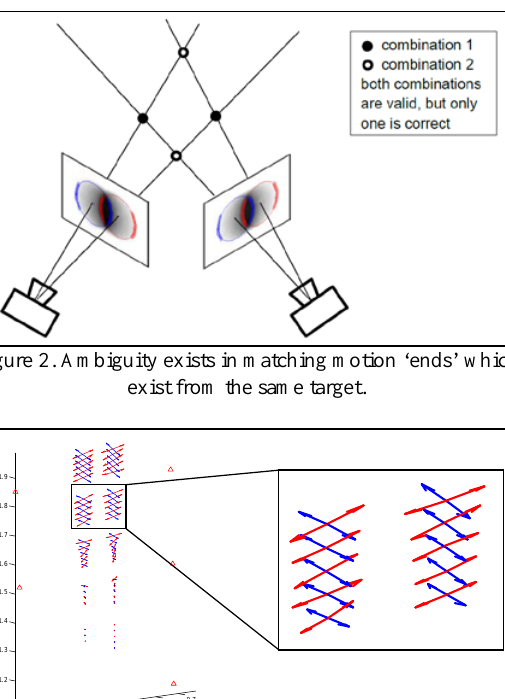
Figure 4. Rotated model fitted to the shaker table